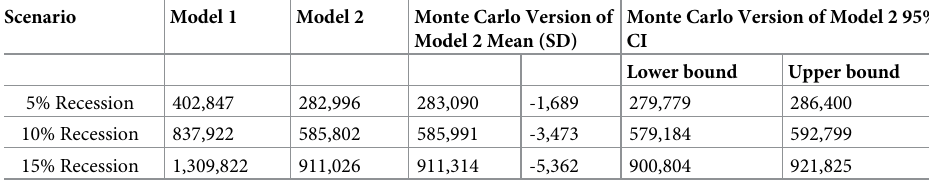
Table 3. Uncertainty analysis from a Monte Carlo experiment using estimates of Model